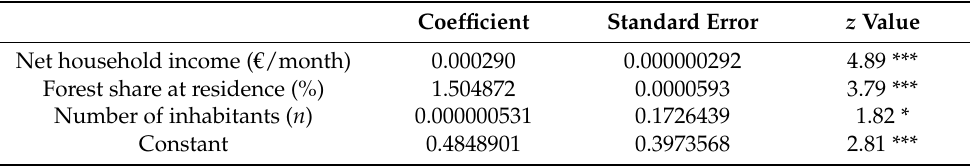
Table 2. Logit regression of the probability of being a forest visitor 1 . Coefficient Standard Error z Value Net household income ( € /month) 0.000290